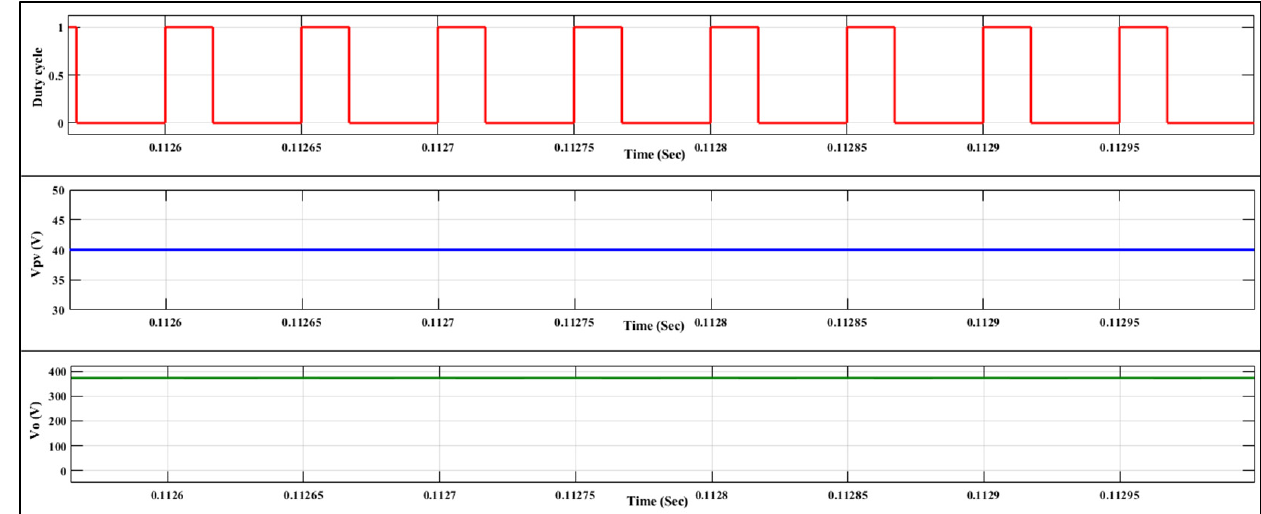
Figure 13. Simulated waveform for solar PV module output voltage (V pv ) and output voltage (V o ) of